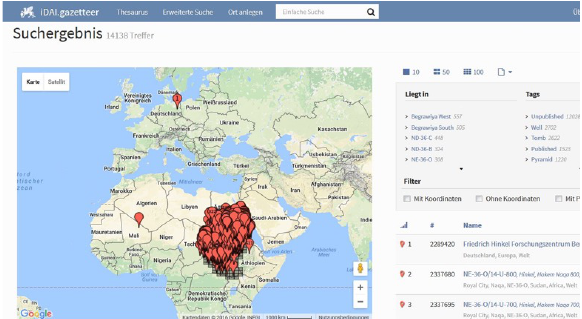
Figure 4. Screenshot of the iDAI.gazetteer showing the point- cloud for the archaeological and historical sites in the